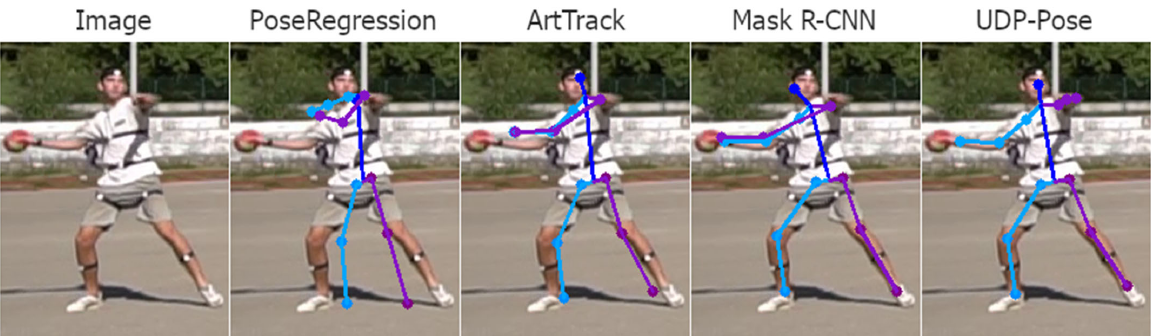
Figure 19. Examples of wrong player side keypoint detection, with an unclear reason for this occurrence. The right side of the player is coloured purple while the left side of the person is coloured blue. While all methods detected almost all keypoints correctly, all methods switched sides of the player, producing an invalid pose. Occurrences of this problem can also be observed on a few keypoints in Figure 18.